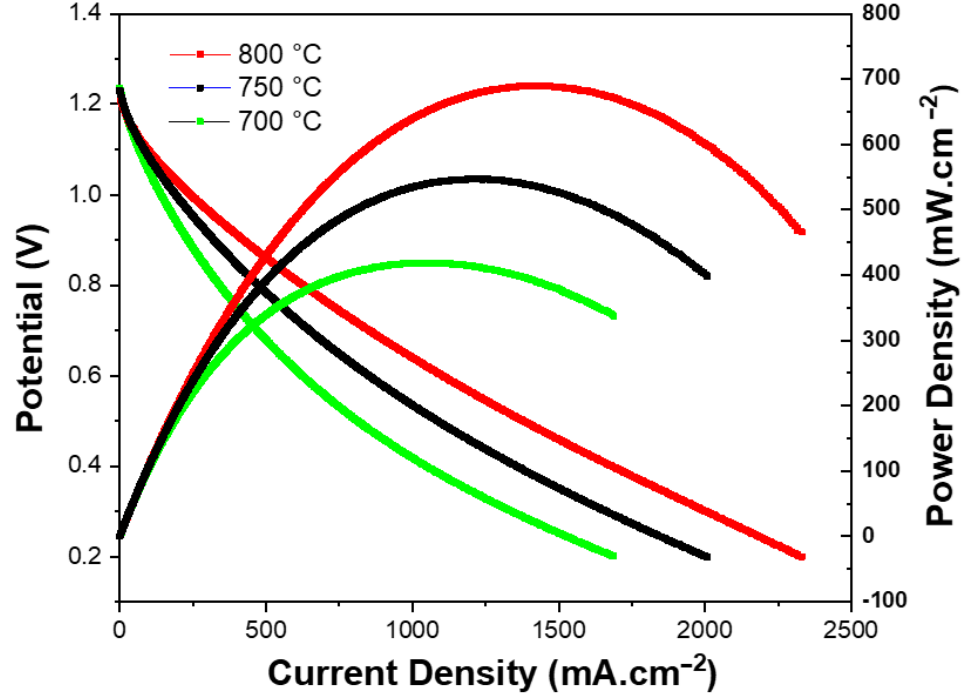
Figure 5. Power generation performance of a single MT-SOC in the temperature range of 700 °C to 800 °C.